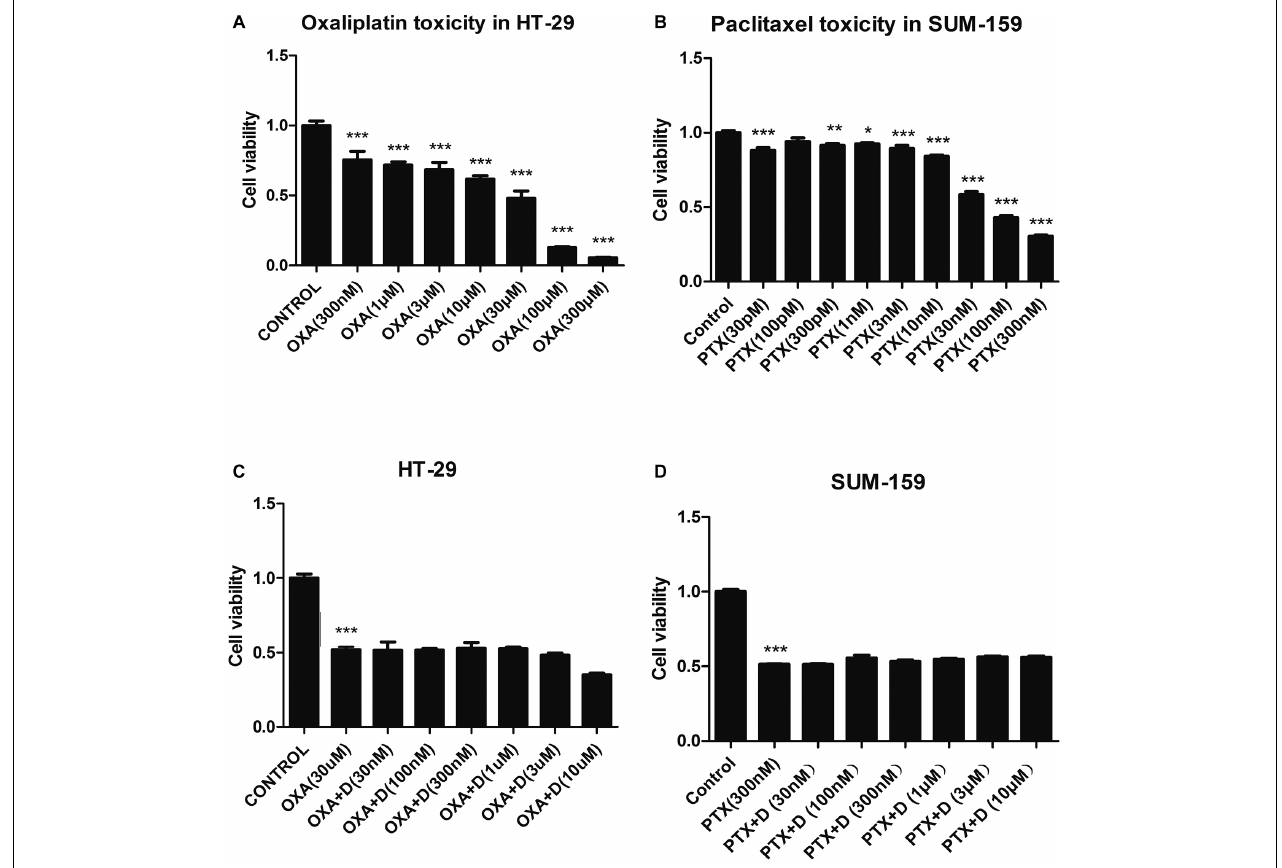
FIGURE 3 | Effect of duloxetine on the anticancer activity of OXA or PTX in vitro . (A,B) When HT-29 or SUM-159 cancer cells were grown in medium, OXA or PTX reduced their cell viability by 20–80%. (C,D) Various concentrations of duloxetine together with OXA or PTX showed no significant changes in cell viability when compared to treatments with OXA or PTX alone. ( ∗ p < 0.05, ∗∗ p < 0.01, ∗∗∗ p < 0.001 vs. control). All the data are the mean ± SEM for each experiment ( n =